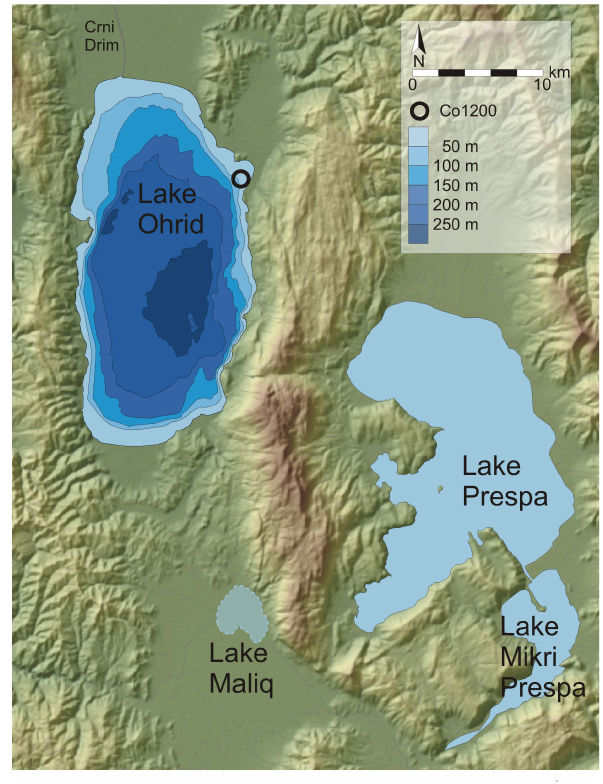
Fig. 1. Location of lakes Ohrid and Prespa and former Lake Maliq in the Macedonian-Albanian-Greek border zone. Shape and topo- graphic setting of Lake Ohrid, bathymetry of Lake Ohrid in 50m contour intervals with the location of coring site Co1200. Note that only the approximate location of former Lake Maliq is